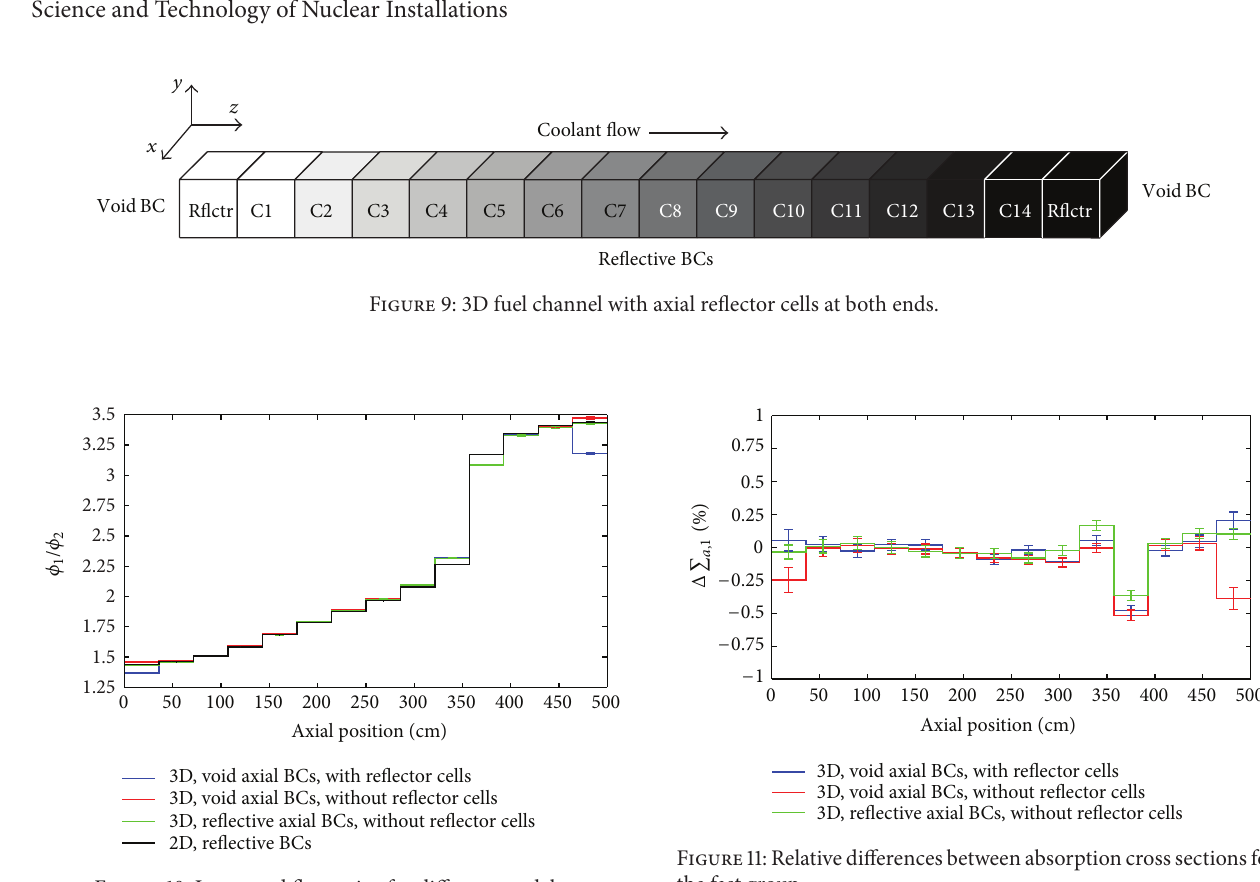
Figure 10: Integrated flux ratios for different models.